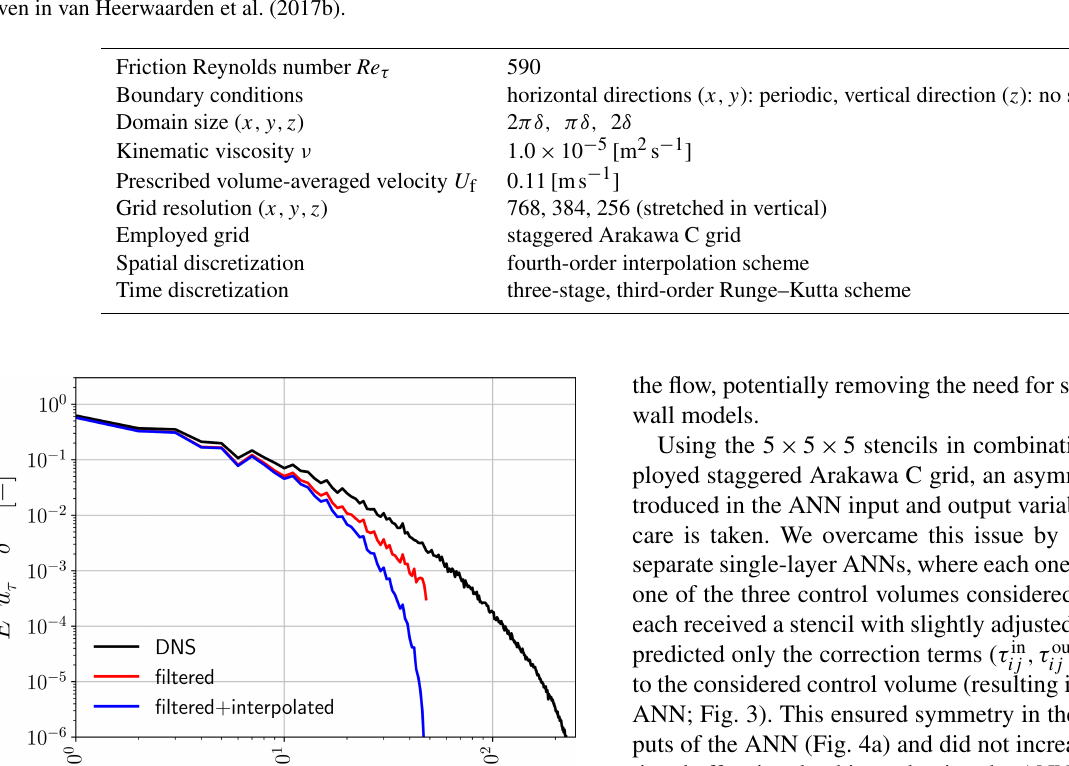
Table 1. Simulation specifications for direct numerical simulation of the incompressible neutral channel flow test case we used to generate the training data (Sect. 3.2). Here, δ [ m ] refers to the channel-half width. Additional details about the employed code (MicroHH v2.0) are given in van Heerwaarden et al. (2017b).